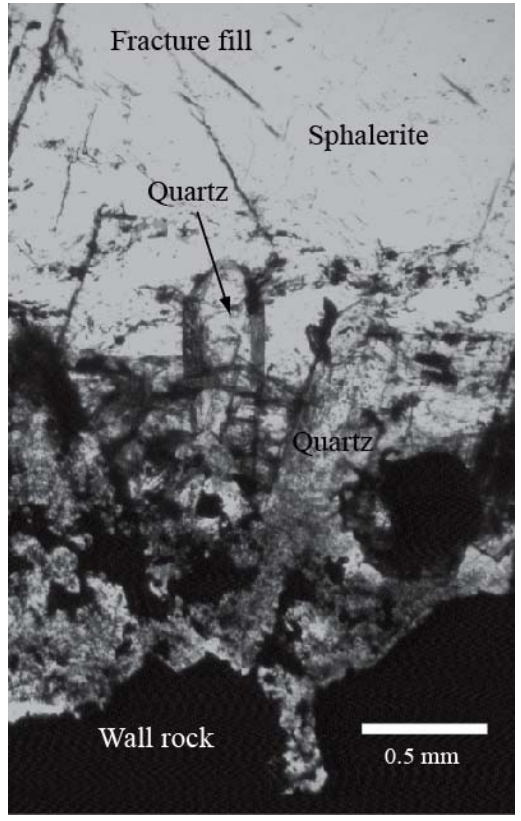
Figure 7. Slightly corroded euhedral pre-mineralisation quartz crystals on the margin of a sphalerite-filled fracture at